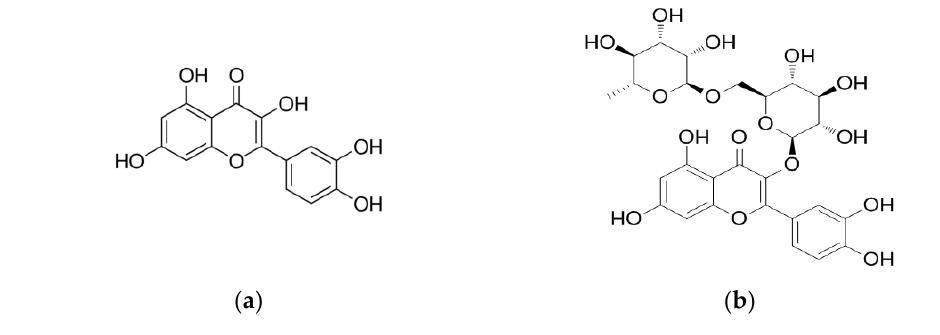
Figure 3. Structures of ( a ) Quercetin and ( b ) Rutin.